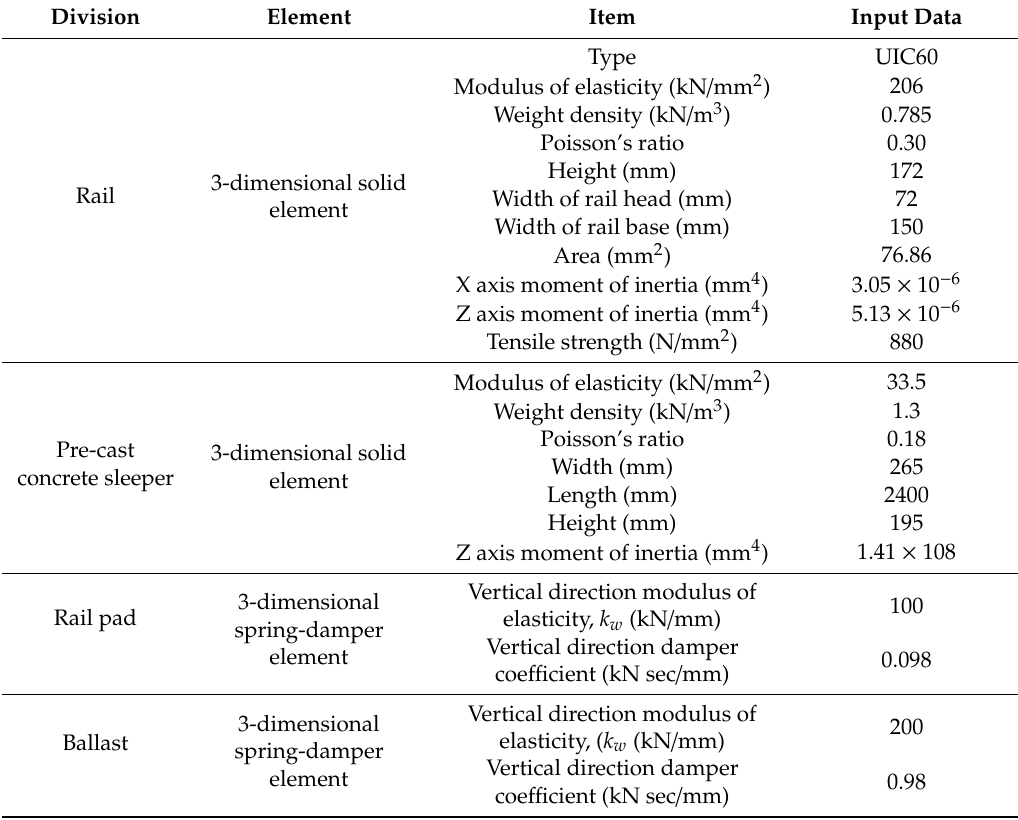
Table 4. Railway bridge design condition for finite element method (FEM)